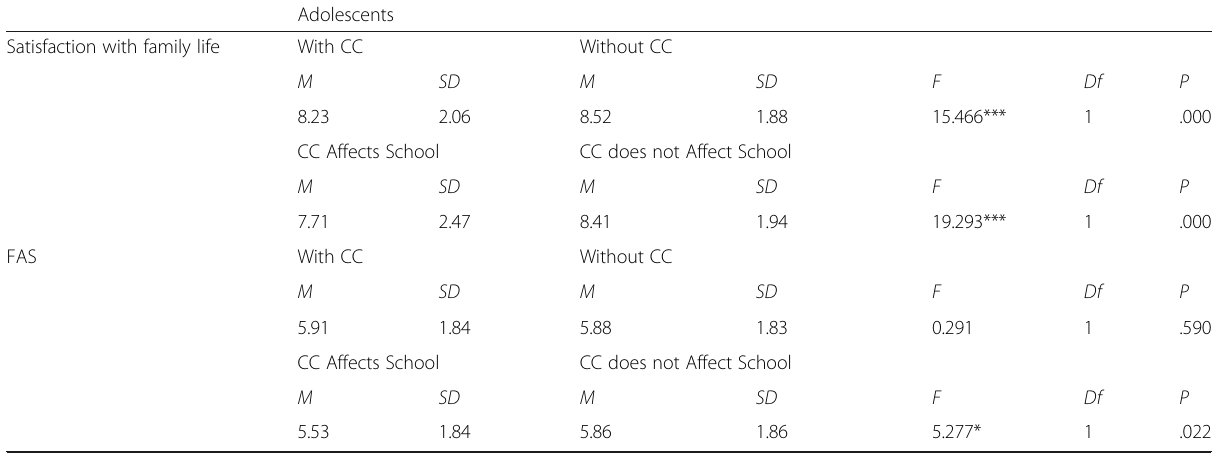
Table 3 Adolescents ’ satisfaction with family life and FAS comparing 1) having or not CC, and 2) feeling that CC affects or not school participation